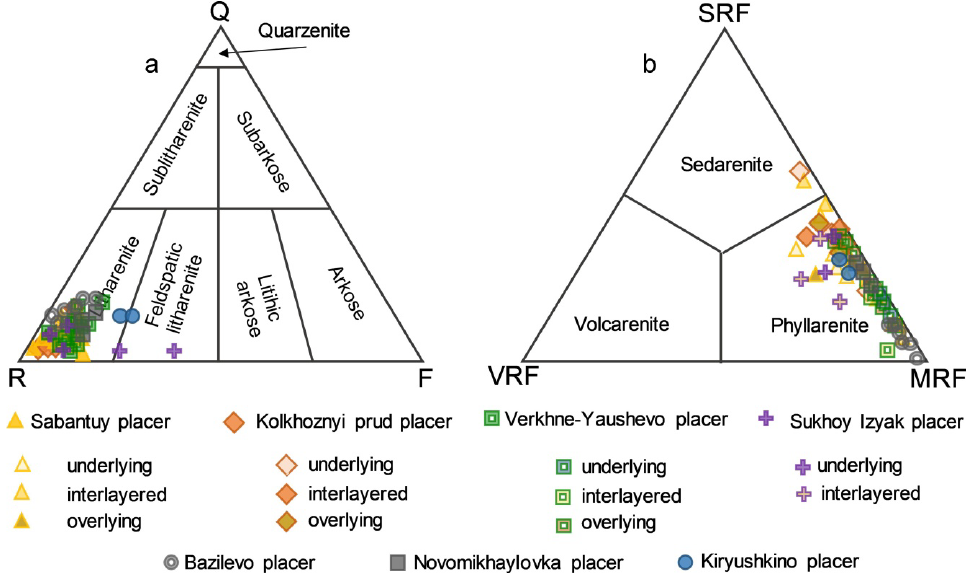
Figure 4. Classification ternary diagrams Q–F–R (Quartz–Feldspar–Rock fragments) ( a ) and SRF–VRF–MRF (Sediment rock fragments–Volcanic rock fragments–Metamorphic rock fragments) ( b )